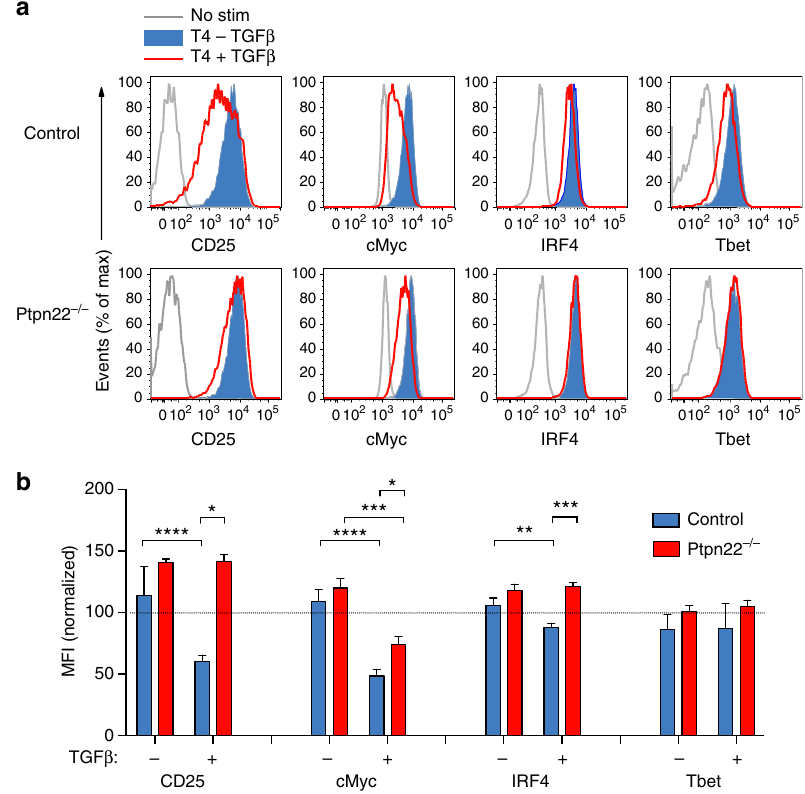
Fig. 2 PTPN22 mediates the extent of TGF β -mediated suppression of early activation markers. a Control and Ptpn22 − / − OT-1 cells were cultured for 24 h with T4 peptide (10 − 6 M) ± TGF β (5 ng/ml). Activation was assessed by upregulation of CD25 and transcription factors c-Myc, IRF4, Tbet by fl ow cytometry. Representative histograms are shown. b Quanti fi cation of MFIs of peptide stimulated cells ± TGF β 5 ng/ml as shown in a (mean and s.d. of three replicates and data representative of 5 experiments). * p < 0.05, ** p < 0.01, *** p < 0.001, and **** p < 0.0001, as determined using two-way ANOVA with Tukey ’ s post test for multiple